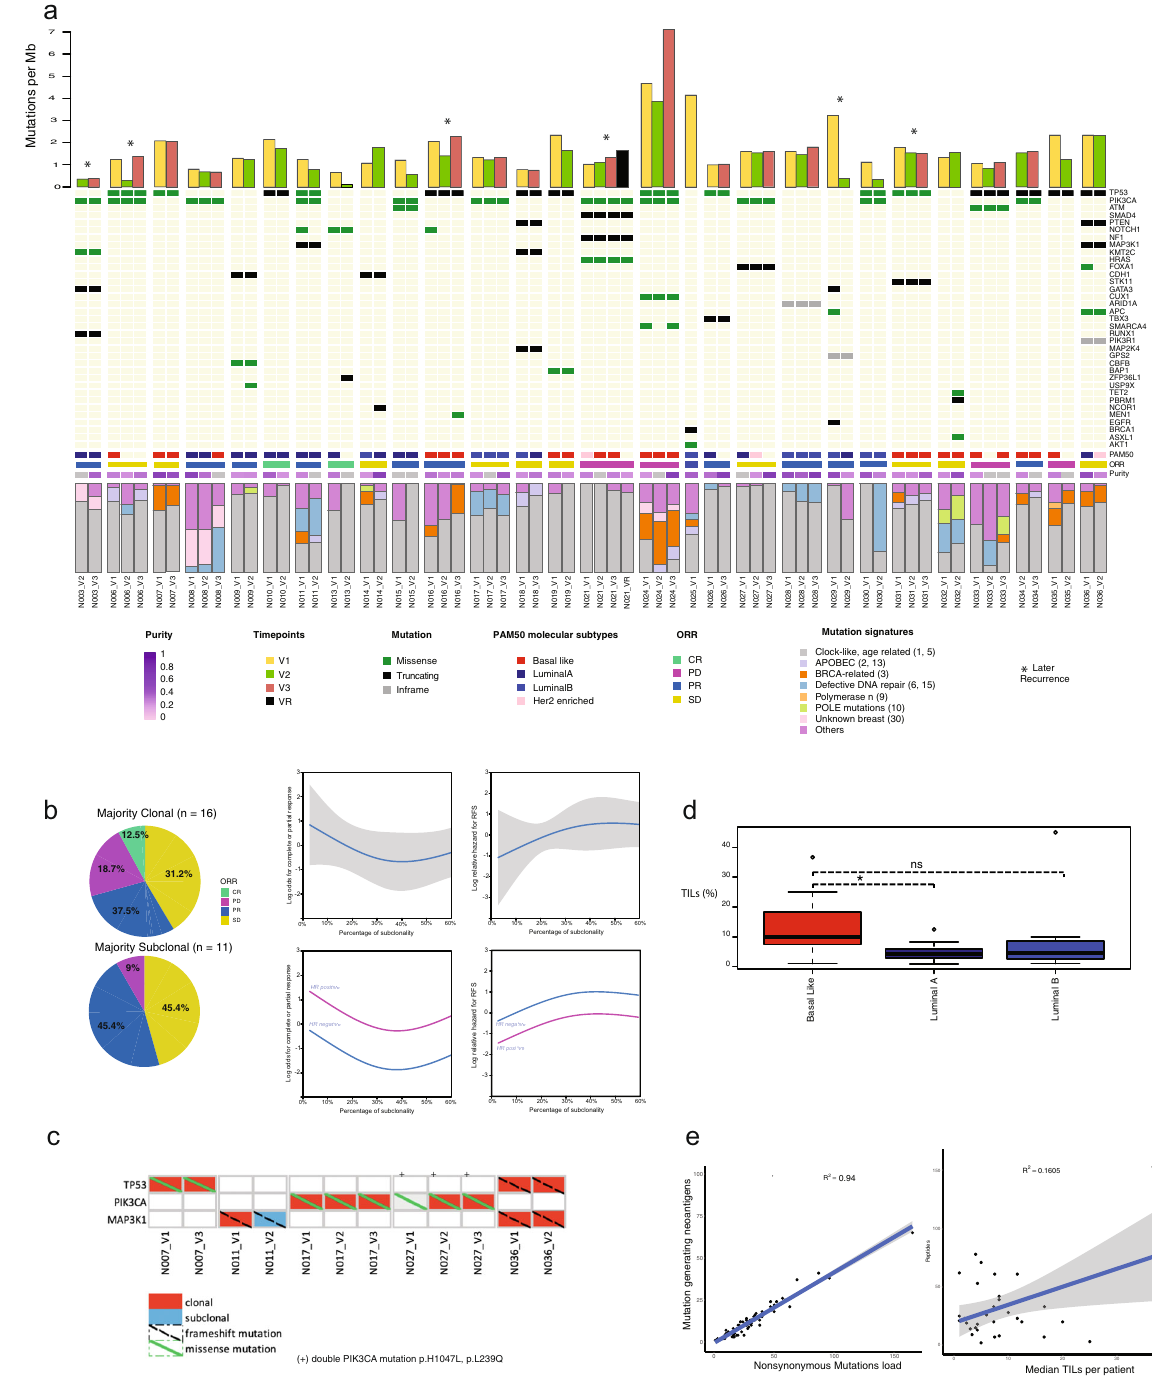
Fig. 2 Mutational landscape of HER2-negative primary breast cancers under neoadjuvant chemotherapy. a Landscape of mutational alterations over time. Stacked plots display mutational burden (top), breast cancer drivers (tile plots, middle), PAM50 molecular intrinsic subtypes, clinical – pathological responses per patient and purity (tile plots, middle), mutation signatures ( fi lled histogram). b Mutation clonality and subclonal distribution across different responses to eribulin. Left panels: odds for complete or partial response; right panels: a relative hazard for relapse-free survival (RFS). The analysis was performed for all comers (top panels) and for HR-positive and HR-negative patients (bottom panels). c Distribution of selected driver mutations generating neoantigens. Driver gene mutations are coloured whether the mutation is clonal or subclonal. d TILs across PAM50 intrinsic subtypes. (*) refer to p value < 0.05; ns nonsigni fi cant. For each box plot, the centre line, the boundaries of the box, the ends of the whiskers and points beyond the whiskers represent the median value, the interquartile range, the minimum and maximum values, and the outliers, respectively. e Relationship between predicted neoantigen load ( y -axis) and nonsynonymous mutational load ( x- axis) and between predicted neoantigen load ( y -axis) and mean stromal TILs per patient ( x